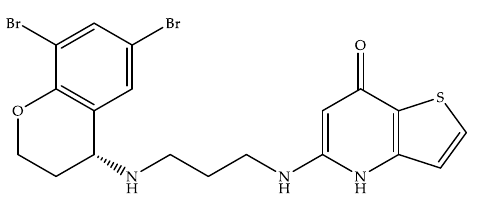
Figure 6. Chemical structure of CRS3123.